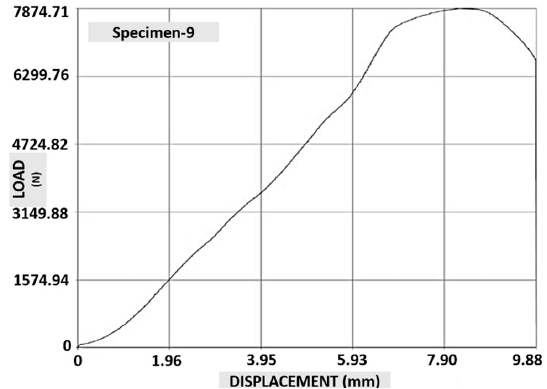
Figure 7. Load vs elongation curve for each specimen of Al6082/2% SiC/2% (CBP/WSP/RHP). Table 5. Experimental value of fabricated composite Al6082/2% SiC/2% (CBP/WSP/RHP).